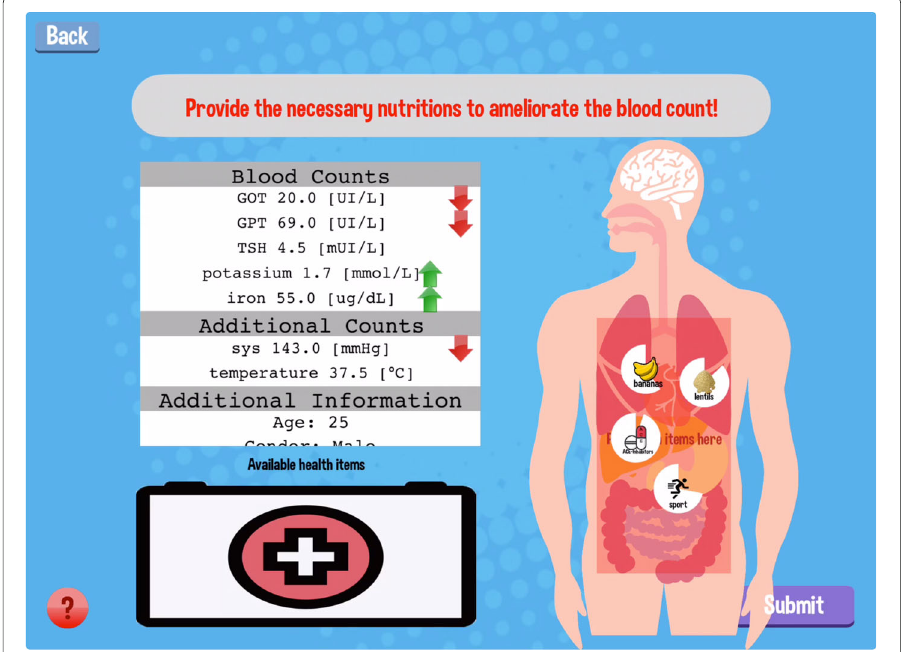
Fig. 5 Blood Count Analysis. A Yactul activity type in the domain of life sciences. Source: (Gashi